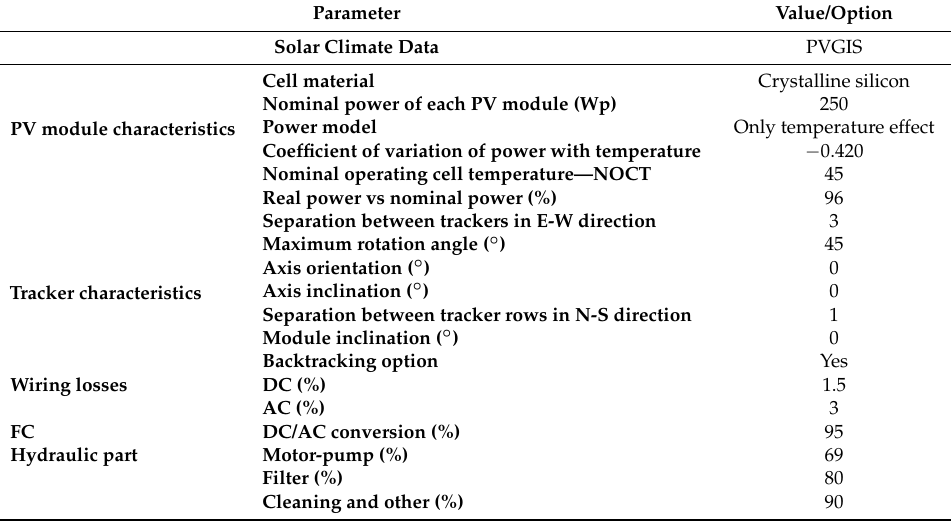
Table 3. Parameters of the